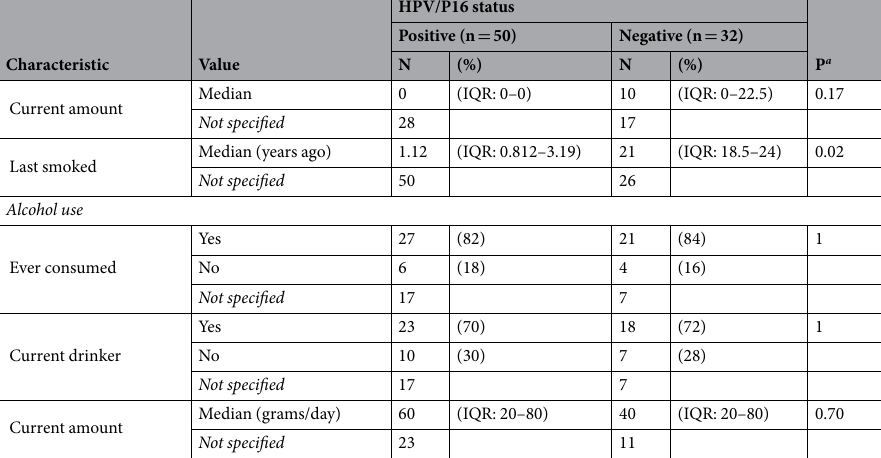
Table 1. The characteristics of HNSCC cohort by HPV/P16 status. NB: IQR: Inter-quartile range; (a) Fisher’s exact test was used for hypothesis testing on categorical and binary data. Shapiro-Wilk test was used to determine the normality for numeric data. One-way Analysis of Variance (ANOVA) and Kruskal-Wallis tests were used to determine the difference between means (normally-distributed) and median (non-normally distributed) data respectively. (b) Significant between-group difference (p < 0.05) on the number of missing values (c) Statistically significant at α =